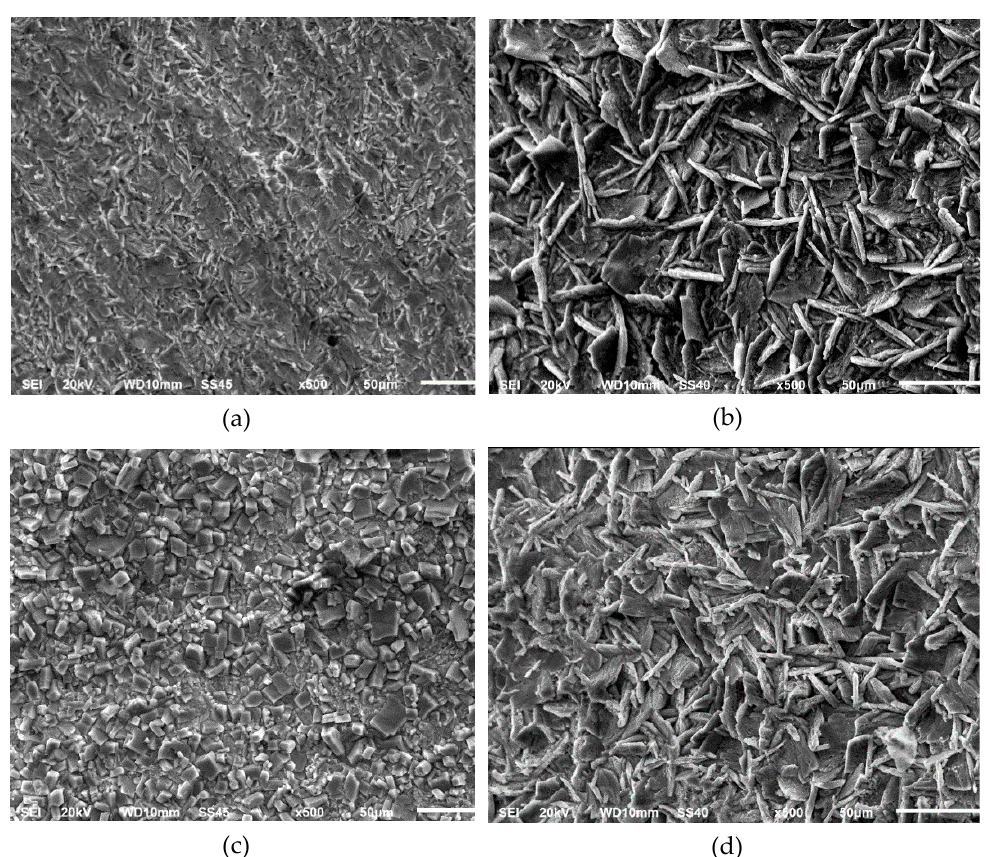
Figure 4. SEM images of the phosphate layers prepared after the citric acid pickling: ( a ) 96.1 g/L—50 °C; ( b ) 96.1 g/L—70 °C; ( c ) 576.4 g/L—50 °C; ( d ) 576.4 g/L—70 °C. Table 8. Quantitative EDS analysis (atomic%) of the phosphate layers obtained after the pickling in citric acid.